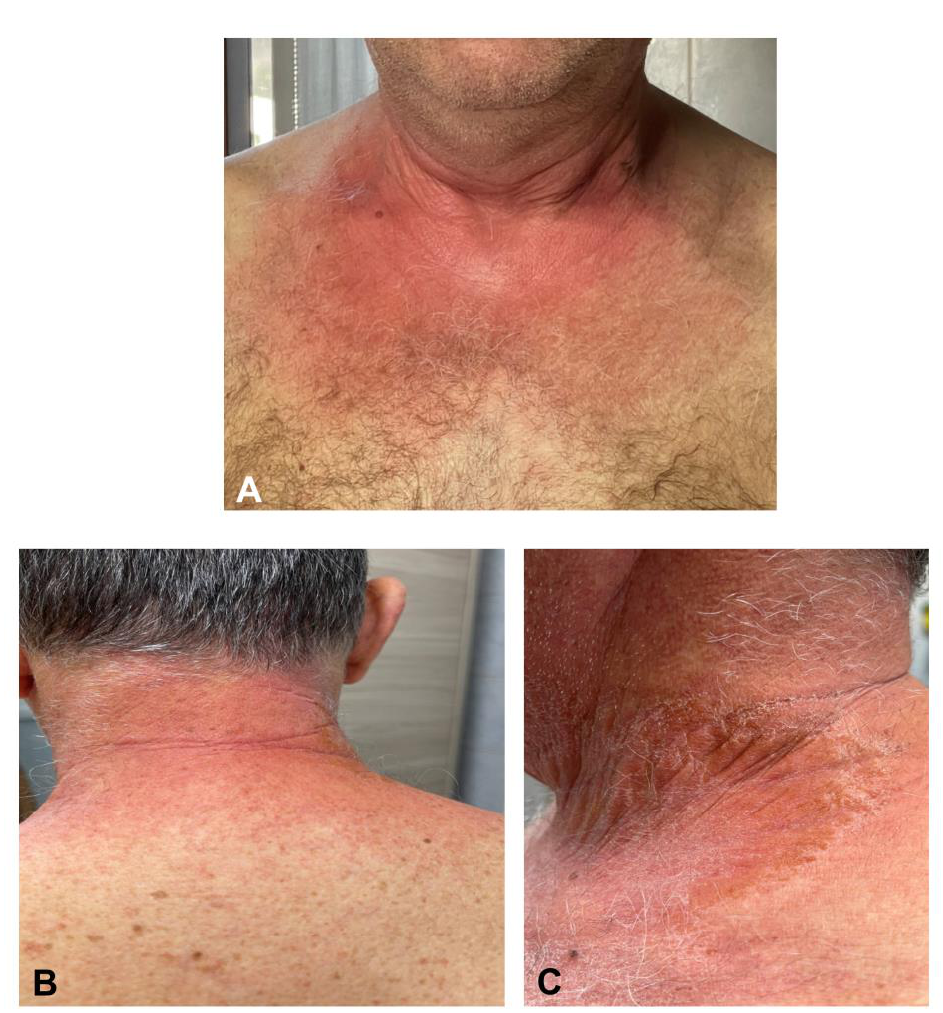
Figure 4. Erythematous and sharply demarcated lesions with symmetric and intertriginous-flexural distribution involving the neck and the gluteal area (symmetrical drug-related intertriginous and flexural exanthema—SDRIFE) developed on a 65-year-old physician two weeks after the BNT162b2 vaccine ( A – C ).